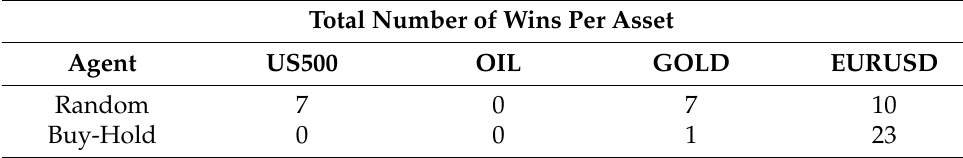
Table 2. Other agents and performance on the given dataset (maximum